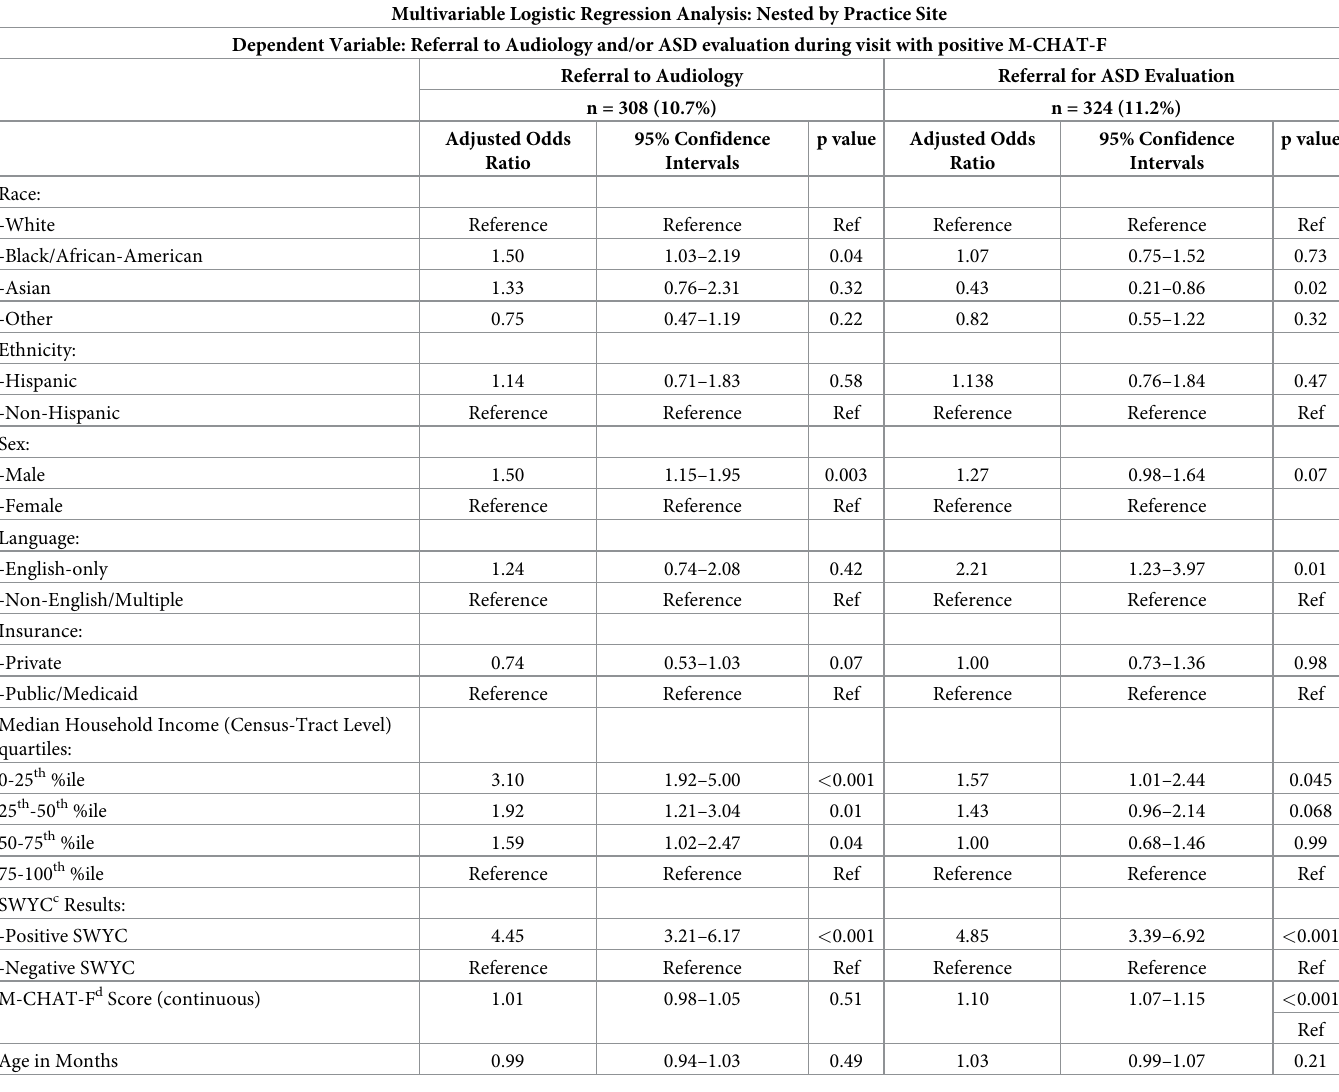
Table 5. Multivariable regression analysis: Factors related to likelihood of referral to audiology and for ASD evaluation after positive M-CHAT-F, (n = 2882) a . Multivariable Logistic Regression Analysis: Nested by Practice